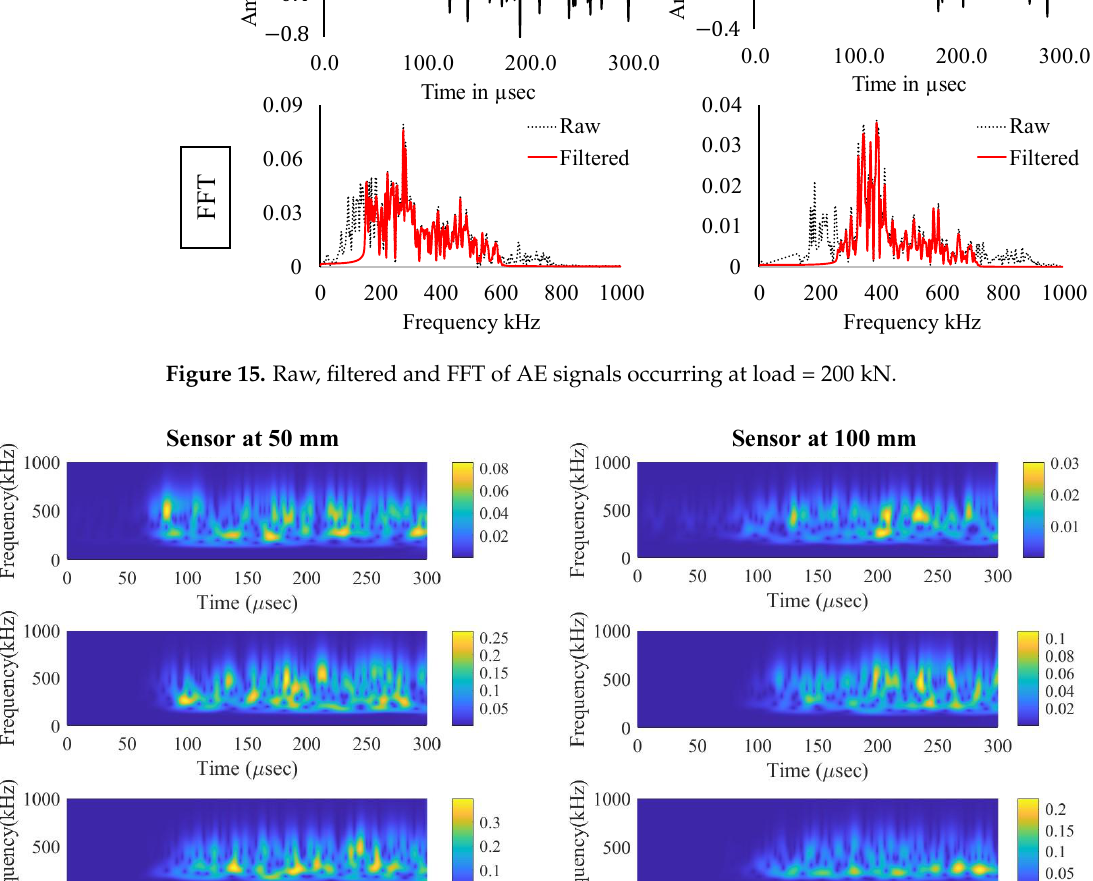
Figure 16. Continuous wavelets transform of AE signals at both sensors.